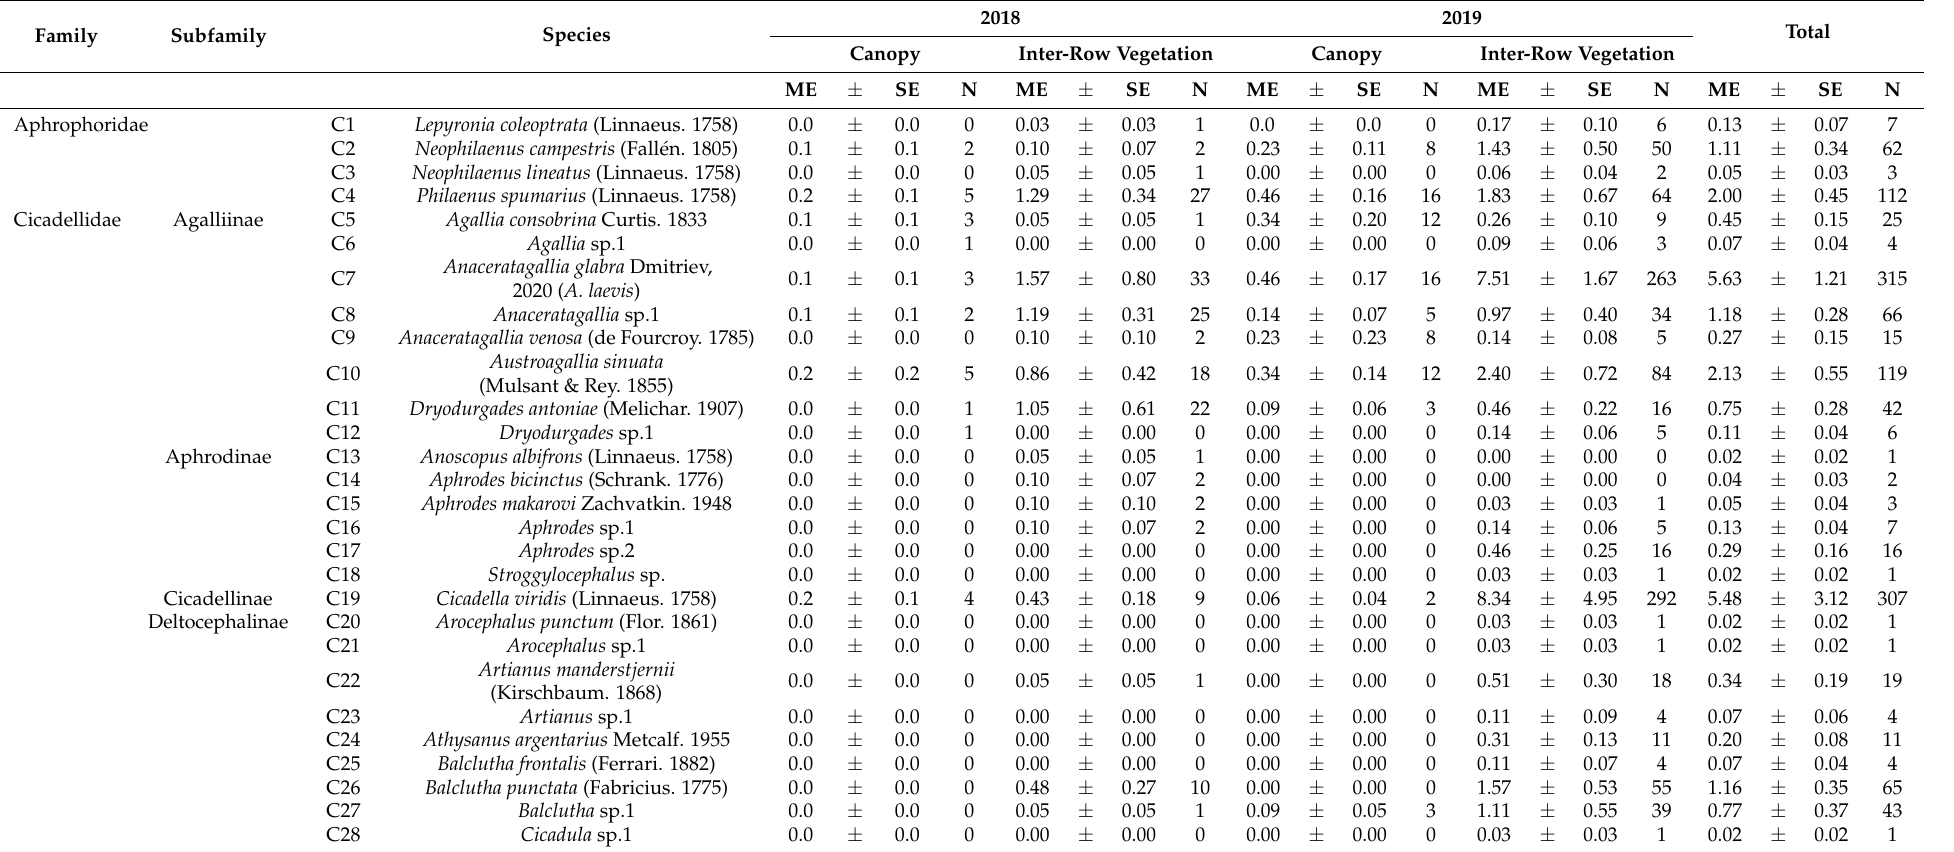
Table 1. Mean and respective standard error (ME ± SE) and total number (N) of Cicadomorpha adults collected in 2018 and 2019 in the vine canopy and inter-row